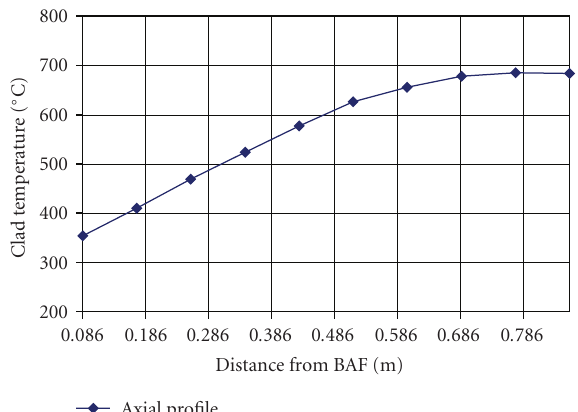
Figure 10: Temperature axial profile—Steady State—Hot Channel.